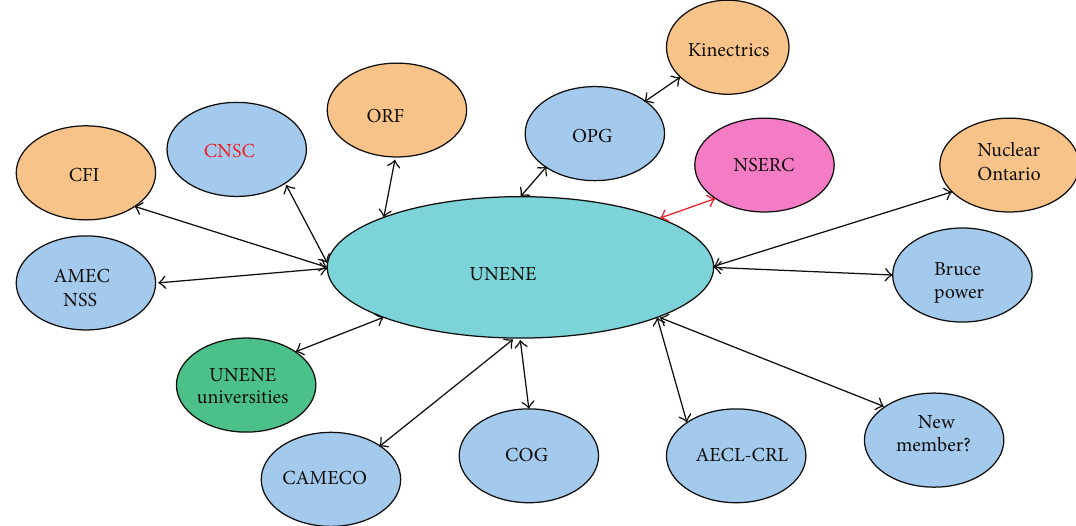
Figure 3: UNENE—an industry-university